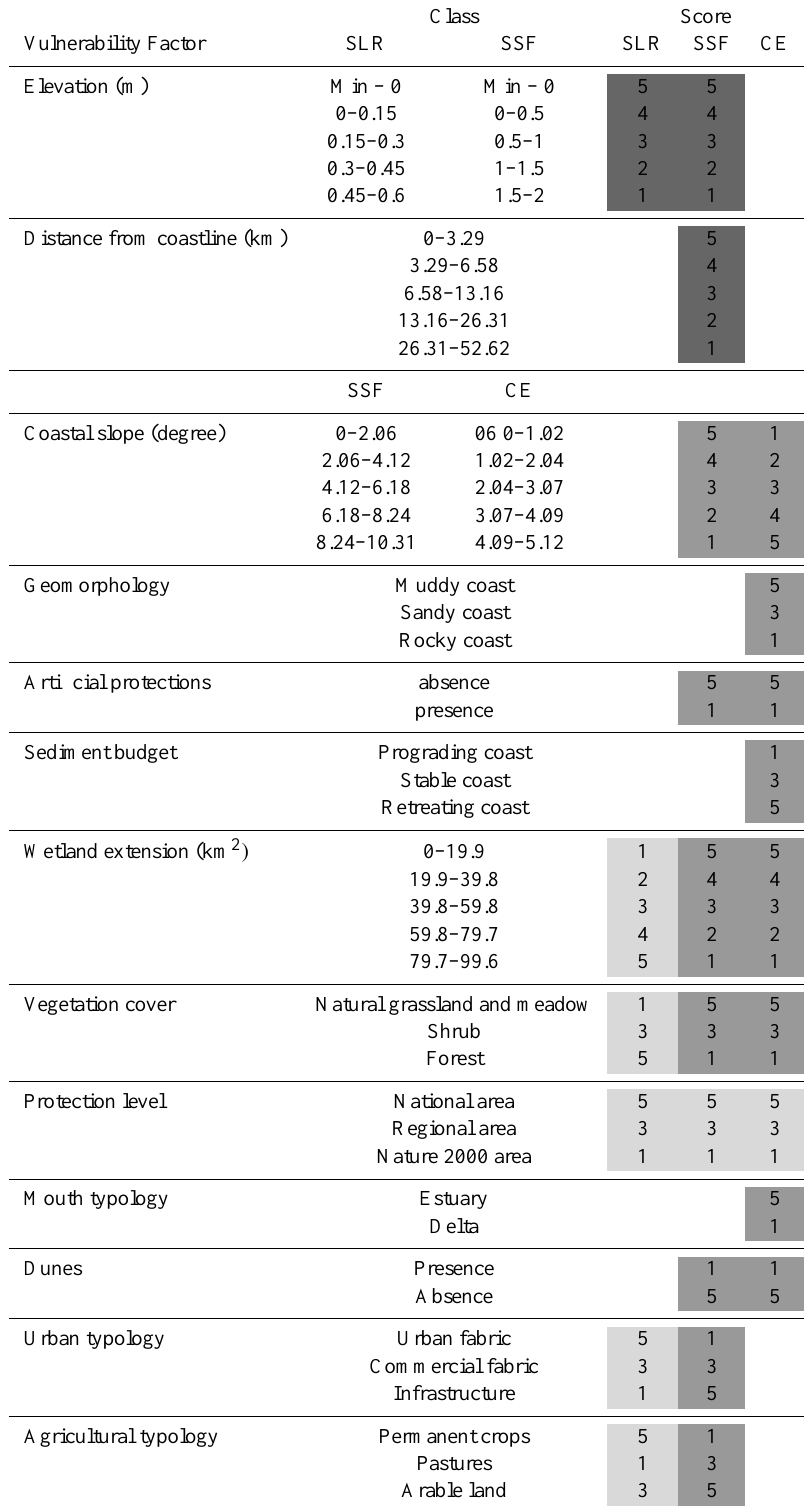
Table 5. Classes and scores applied to vulnerability factors used in the North Adriatic in order to estimate the vulnerability of coastal receptors to the following climate change impacts: sea level rise inundation (SLR); storm surge flooding (SSF); coastal erosion (CE). Scores refer to pathway factors (dark grey cells), susceptibility factors (grey cells) and value factors (light grey